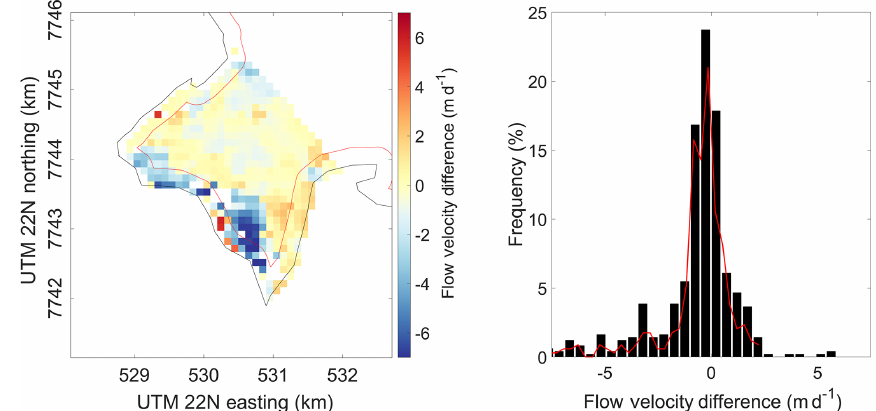
Figure 7. Distribution of flow velocity differences between S-1A satellite-based and UAV-based calculations. Negative values denote higher flow velocities from the UAV dataset, and positive values denote higher values based on the SAR data. The red line in the histogram shows the distribution of values when a 250m buffer zone at the glacier’s margins was excluded.